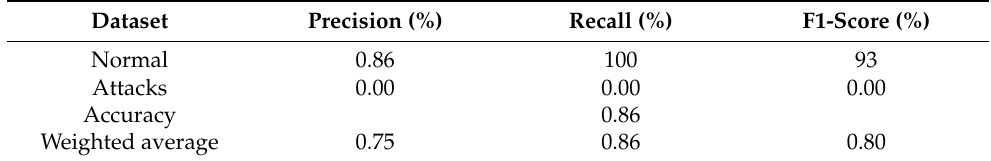
Figure 8. Correlation features of the dataset. Table 8. Results of the proposed system for the validation phase.